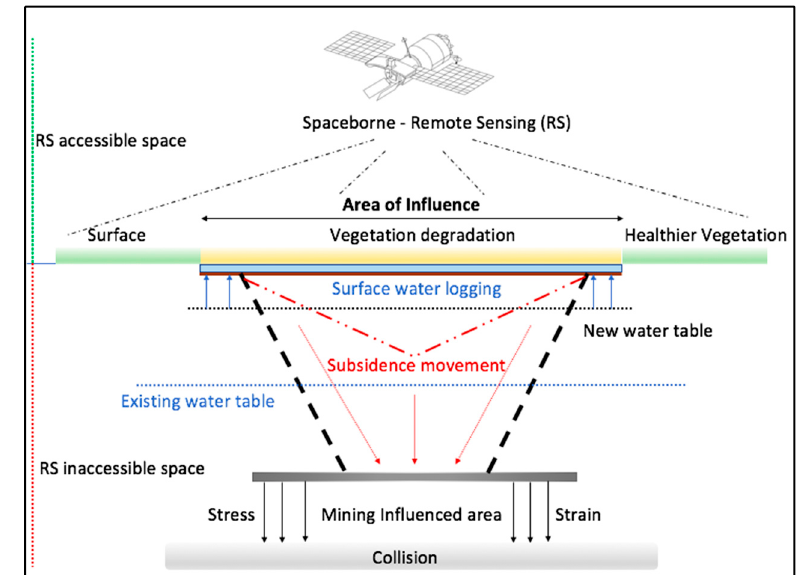
Figure 1. Inundation and subsidence through geological changes in a mining-affected area. The changes observed in the surface level using remote sensing (RS) may indicate the geological changes at the subsurface level. The figure is created according to the description of subsidence in Brunn et al. (2002) [4].